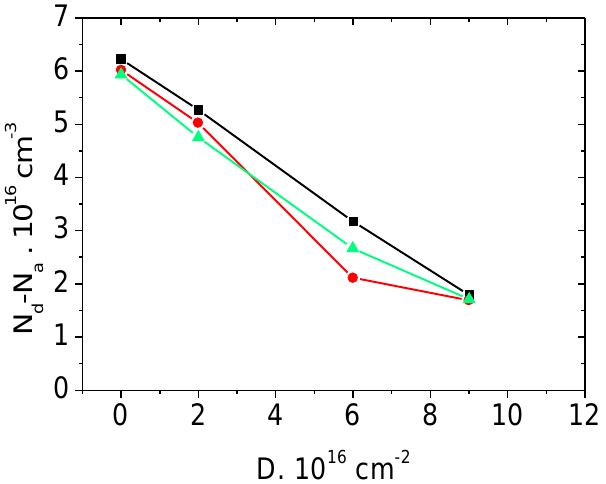
Figure 3. Dependence of the concentration N d – N a in Schottky diodes (CREE) with the blocking voltage of 600 V. Irradiation with protons at room temperature. Different symbols correspond to different diodes from the same batch.